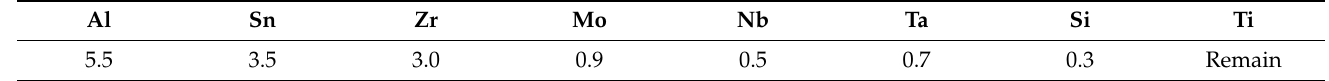
Table 1. Main chemical composition of TA32.